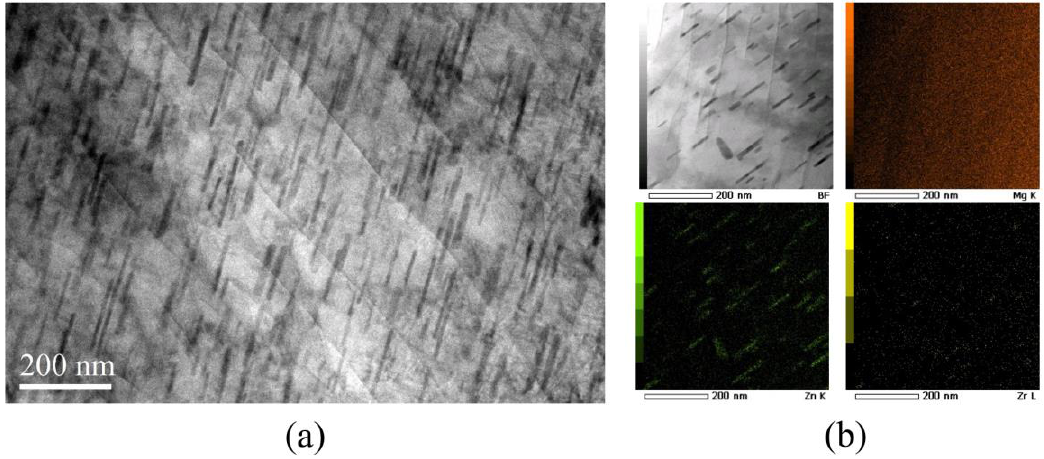
Figure 4. ( a ) TEM image and ( b ) STEM/EDS mapping of cast ZK60 Mg alloy.